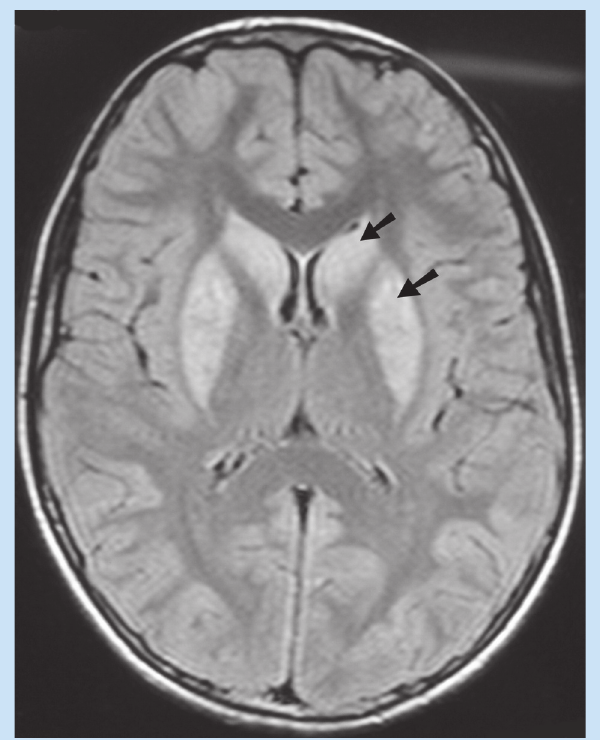
Fig. 2.4g. Fluid-attenuated inversion recovery (FLAIR) demonstrates bilat- eral symmetrical involvement of the basal ganglia associated with severe hypoxia.